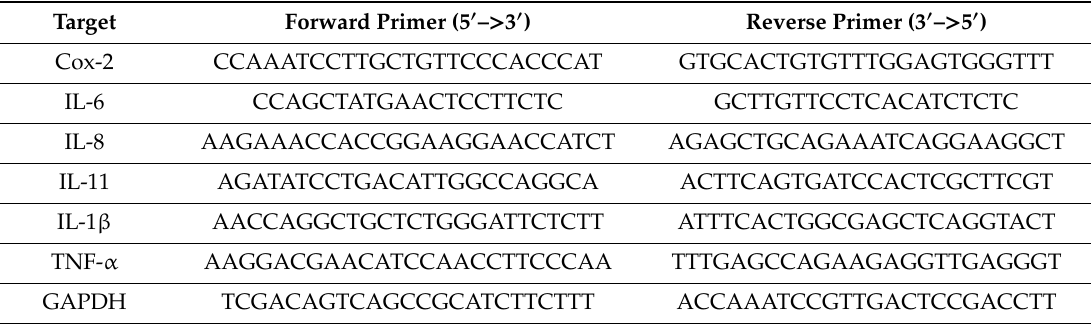
Table 1. Primers for real-time